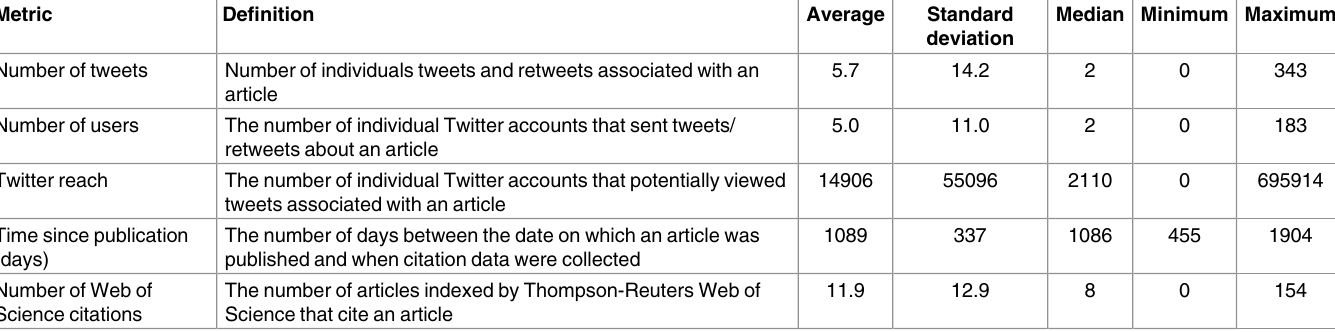
Table 1. Definitions and summarystatistics of variables used in generalized linear mixed models predicting citation rates of ecological research articles.